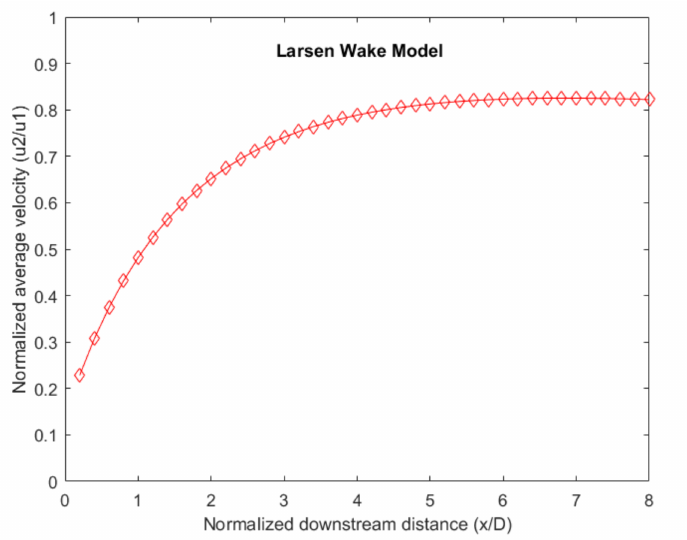
Figure 13. Normalized average velocity profile for the Larsen wake